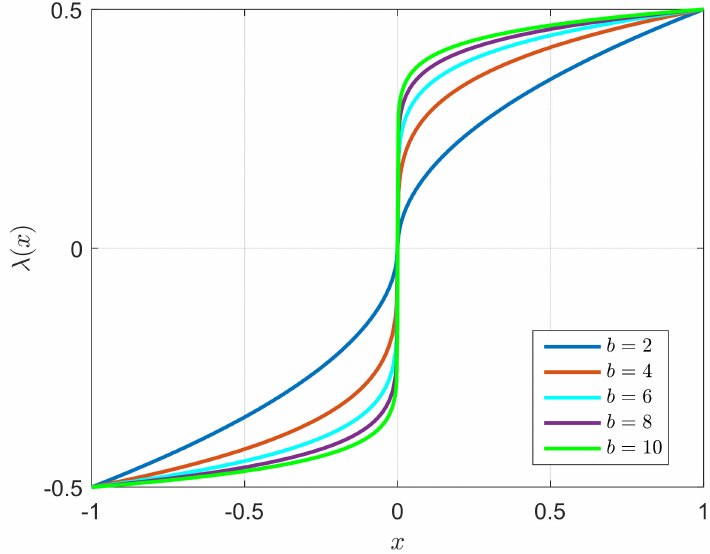
Figure 2. The change curves of λ ( x )